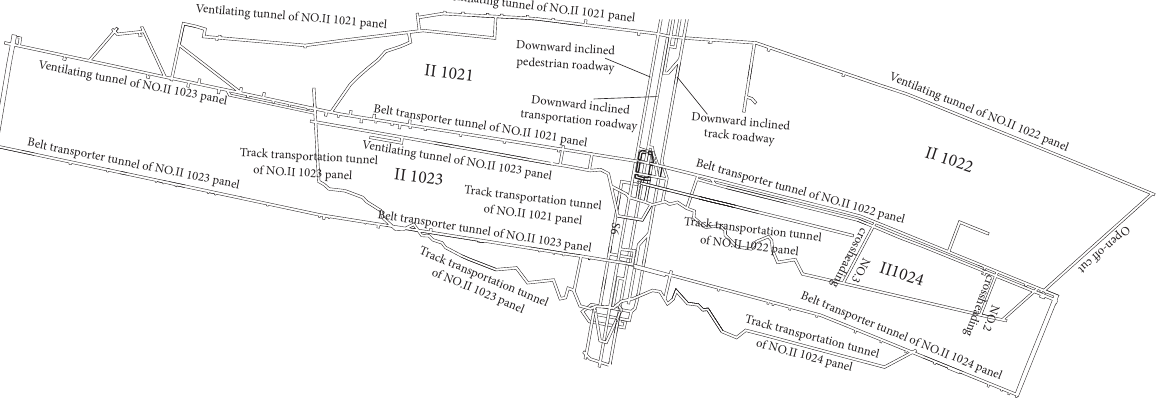
Figure 3: General layout of the No. 2 102 Mining Area.